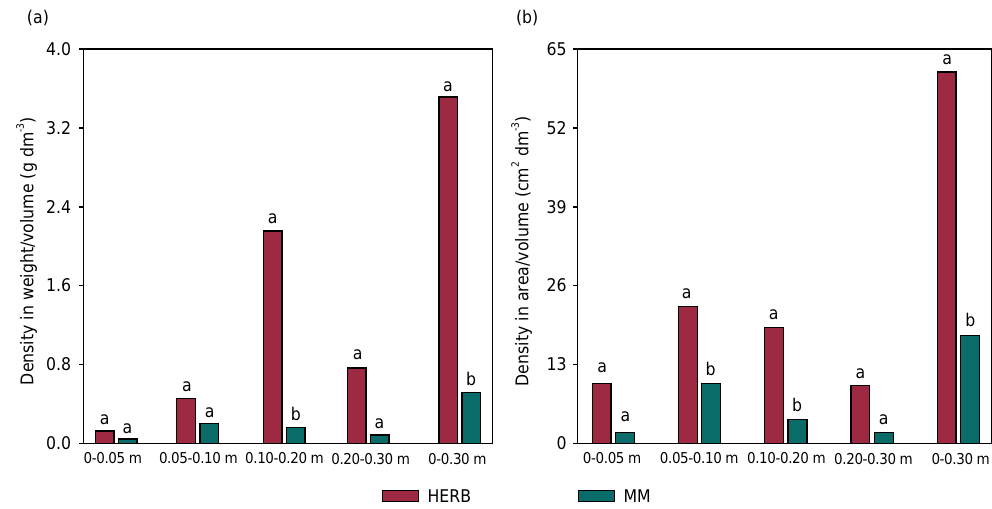
Figure 4. Density in weight/volume (a) and density in area/volume (b) for the roots of early dwarf cashew under different management systems in an area cultivated with early dwarf cashew in Pacajus, Ceará, Brazil. DH: disc harrowing; MM: mechanical mowing + crowning; HERB: Herbicide. Mean values followed by the same letter in the soil layers do not differ by